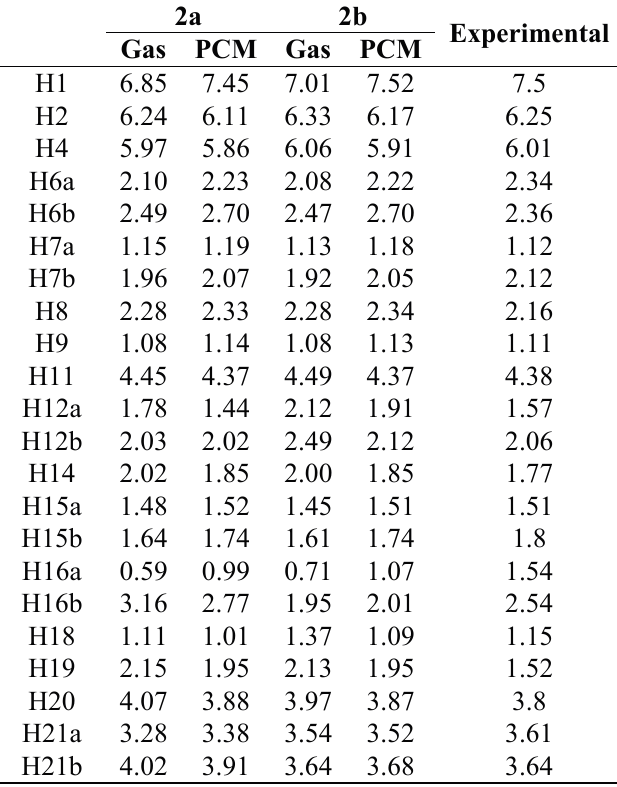
Table 2. Experimental and predicted 1 H-NMR chemical shifts ( δ ppm) of stereoisomers 2a and 2b obtained at the B3LYP/6–31+G(d,p) level of theory.